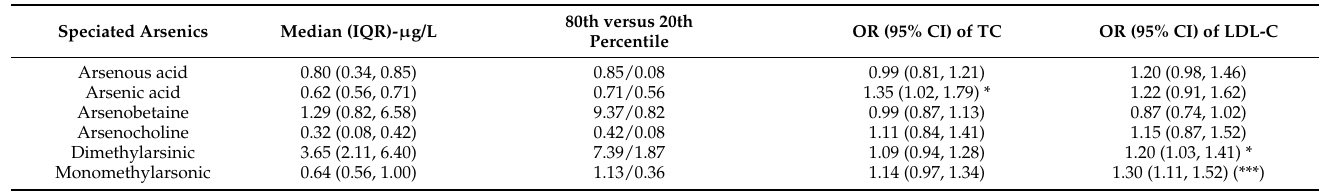
Table 5. Unadjusted odds ratios (OR) and 95% confidence intervals (CI) of the association between TC and LDL-C and speciated arsenic.